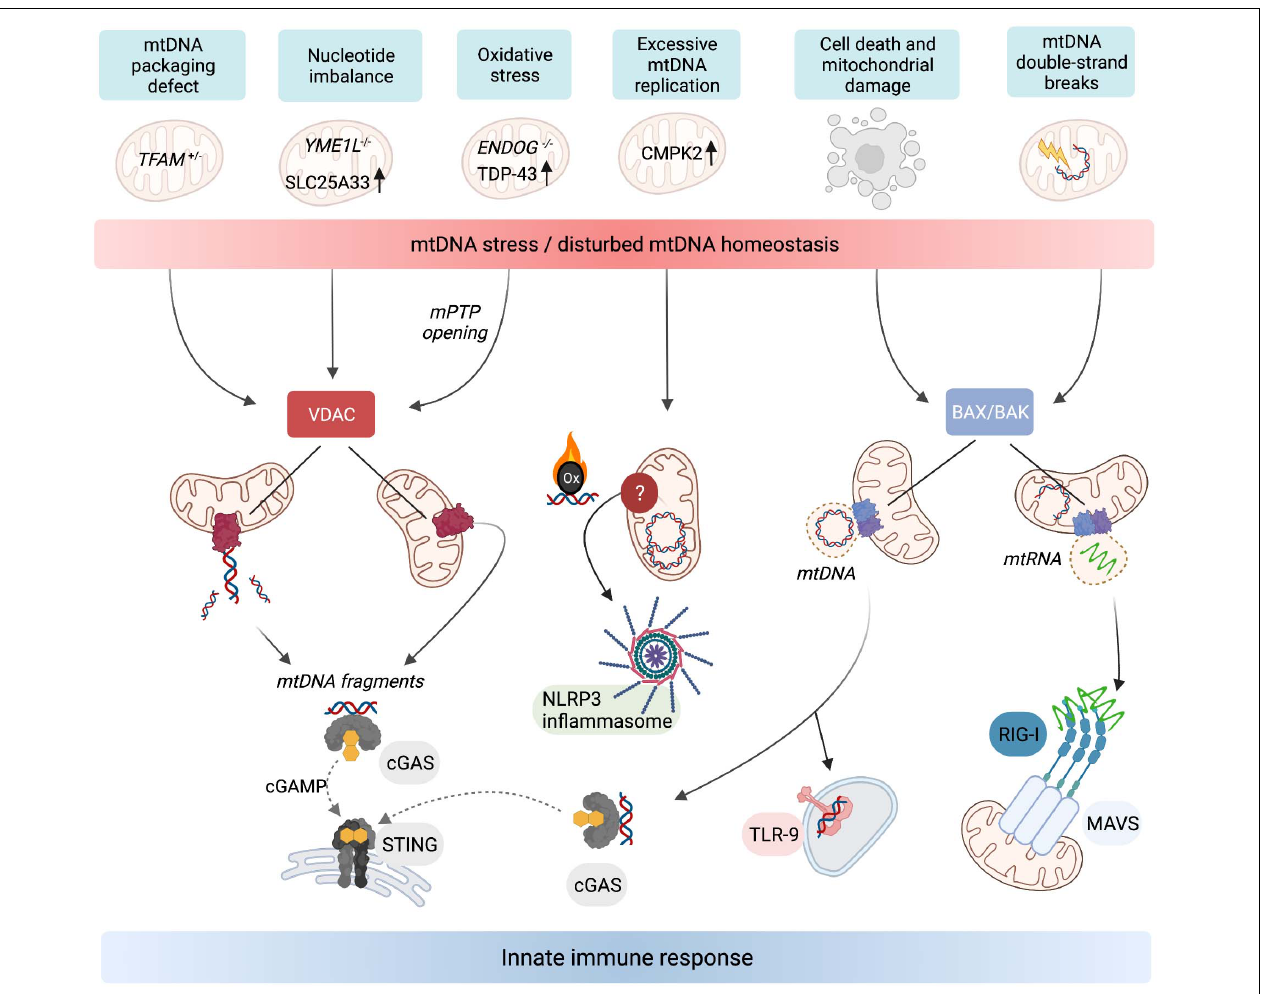
FIGURE 2 | Release of mtDNA/RNA and the induction of innate immunity. Stressors, genetic, and metabolic perturbations triggering mtDNA/RNA-dependent innate immune responses. Fragments of mtDNA and mitochondrial nucleoids can be released along different pathways. VDAC oligomerisation at the OM allows the release of mtDNA fragments, which also requires concurrent opening of the mPTP in the mitochondria of ENDOG - / - cells and neurons expressing mutant mitochondrial localised TDP-43. Oxidised mtDNA fragments are also released in macrophages undergoing excessive mtDNA replication and trigger the NLRP3 inflammasome. TFAM-bound mtDNA nucleoids are released from mitochondria in response to cell death signalling upon herniation of the IM through BAX/BAK pores in the OM. If the cell does not undergo apoptosis, the cytosolic mtDNA triggers innate immune signalling upon recognition by DNA-binding receptors including cGAS and